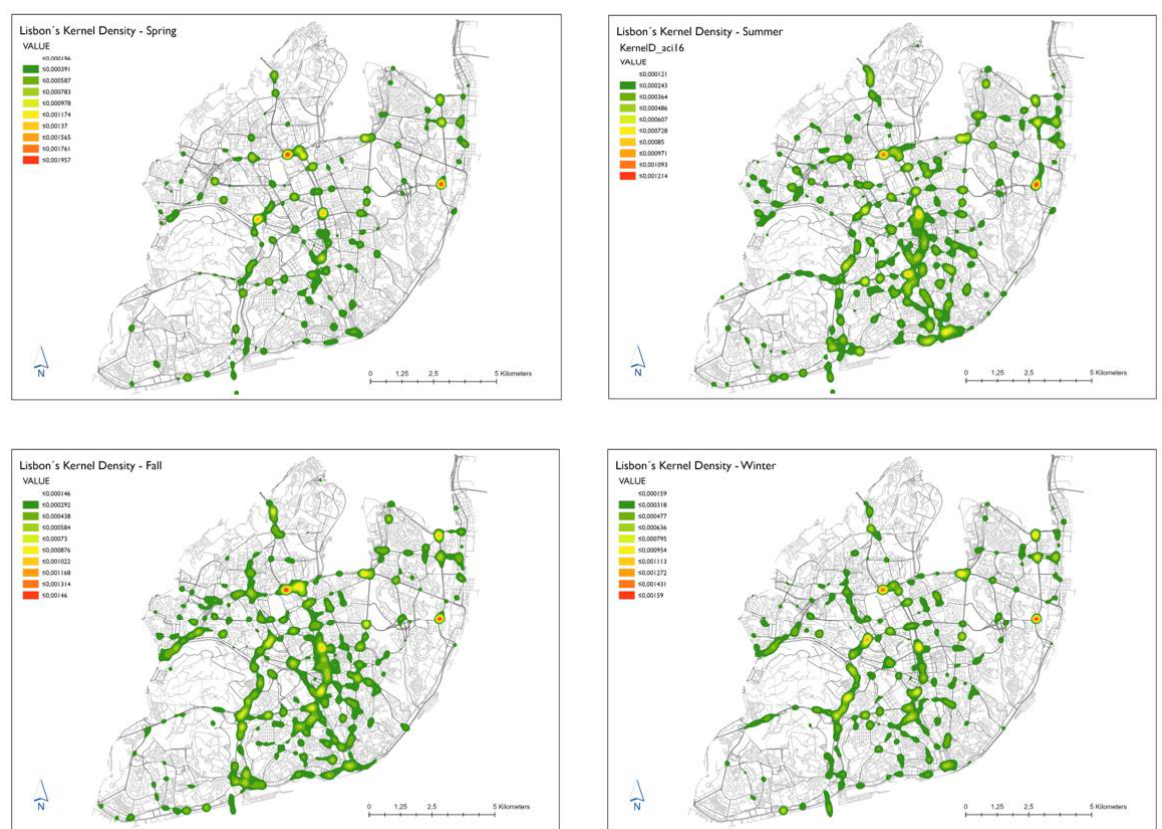
Figure 5. KDE analysis seasonal analysis 2010 – 2019.